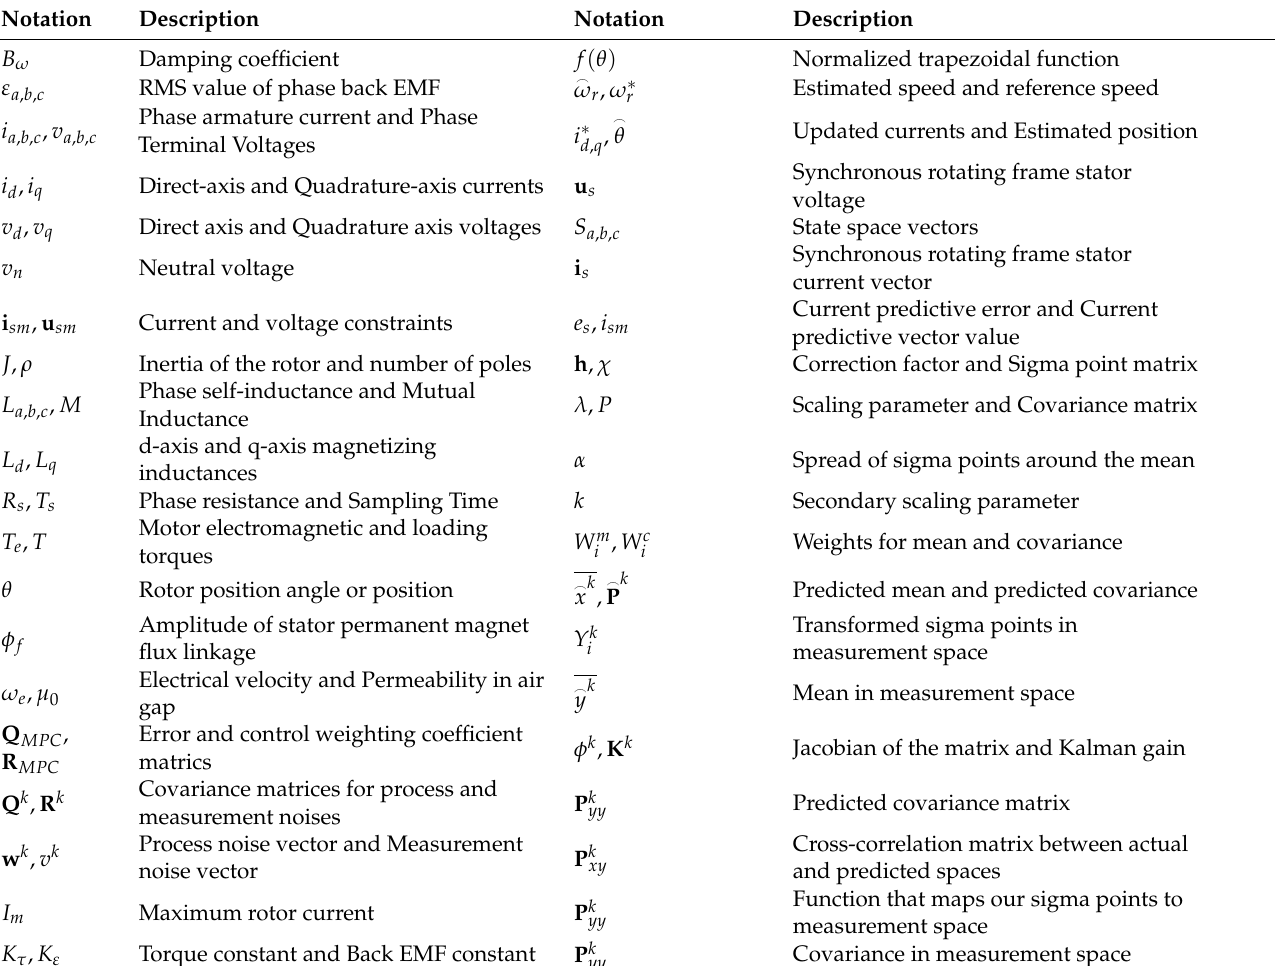
Table 2. Notations used in the System